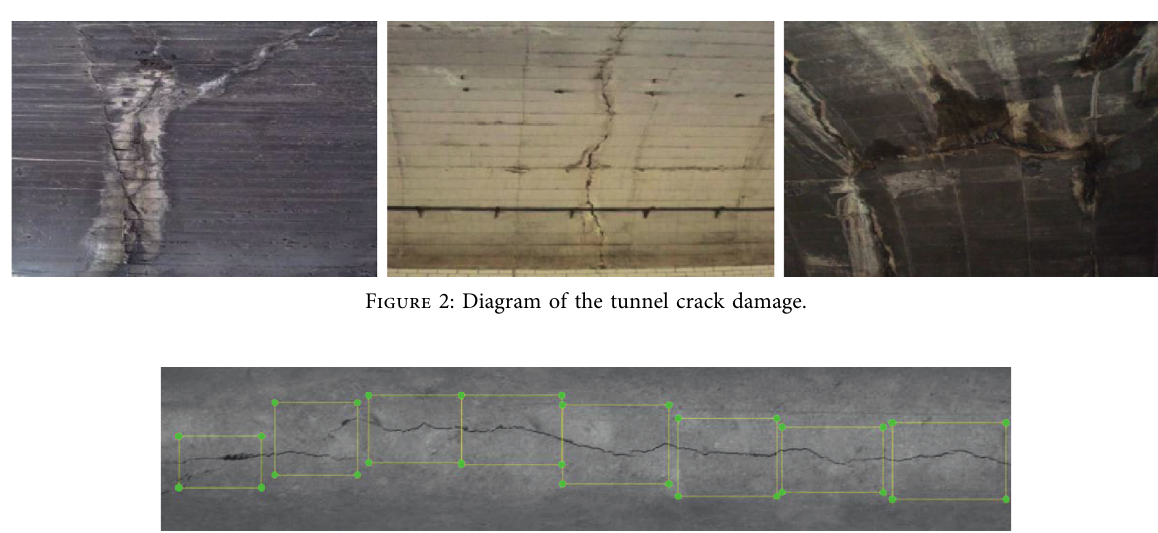
Figure 3: Marking cracks.